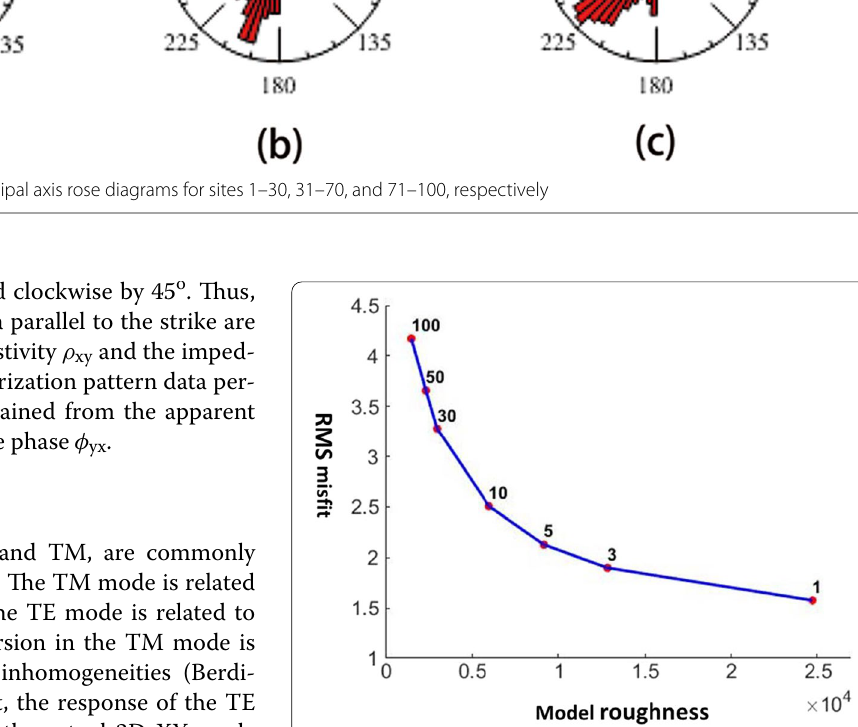
Fig. 6 L-curve between Model Roughness and RMS